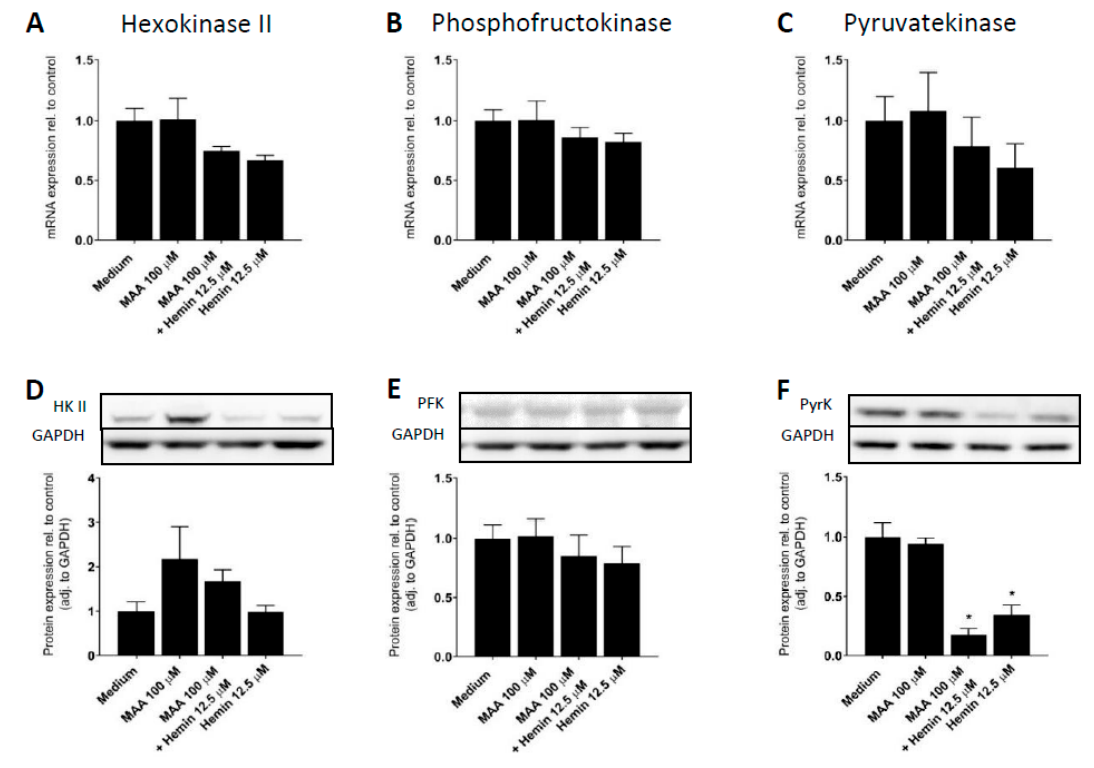
Figure 5. Effect of MAA and/or hemin on mRNA and protein expression of key enzymes of glycolysis in HL60 cells. HL60 cells were treated with the toxicants for 24 h. mRNA expression was determined by quantitative real-time PCR and protein expression by Western blotting. ( A – C ) mRNA expression of hexokinase II, phosphofructokinase and pyruvate kinase. ( D – F ) protein expression of hexokinase II (HKII), phosphofructokinase (PFK), and pyruvate kinase (PyrK). n = 3 blots per column. Values are given relative to control incubations treated with vehicle only and are presented as mean ± SEM. * p < 0.05 vs. vehicle-treated control incubations (medium).